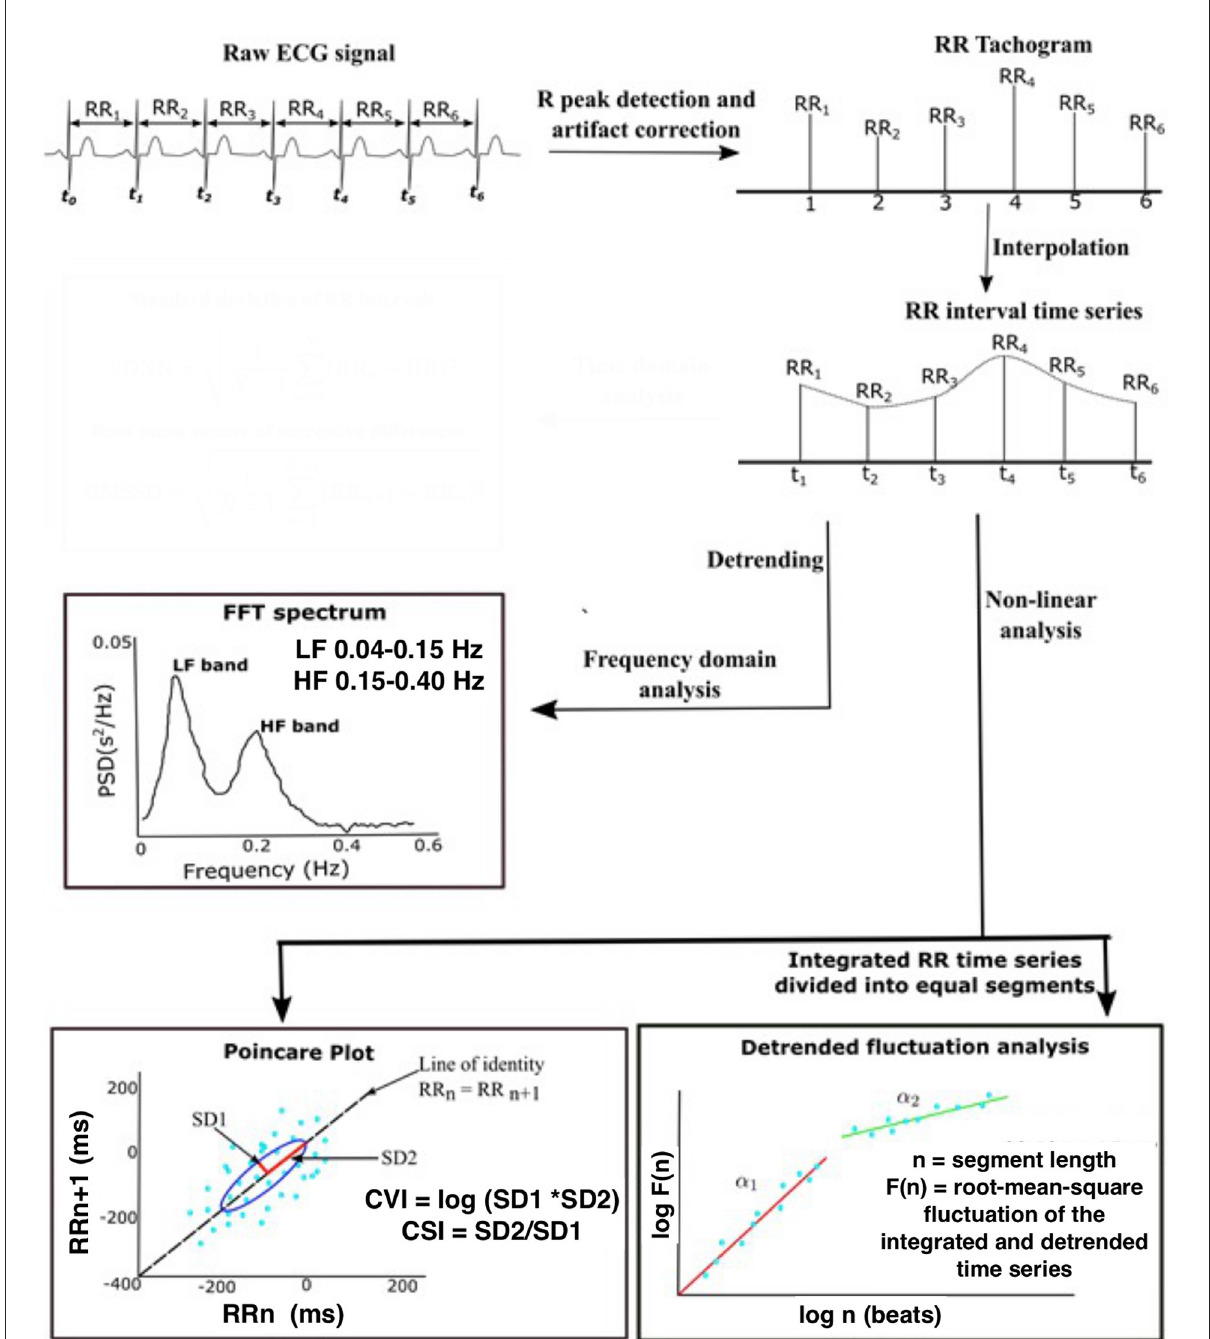
FIGURE1 Schematic demonstrating the steps in the analysis of heart rate variability. Raw ECG data were sampled at 256Hz and the 5min segment of ECG recordings was extracted from seizure-free epochs during NREM sleep. Pan–Tompkin’s algorithm was applied to compute RRi and generate an equidistantly sampled RR time series. Standard frequency domain HRV measures included normalized power of variability in two standard frequency bands HF (0.15–0.4Hz) and LF (0.04–0.15Hz). The Poincaré plot is a scatter plot representing the correlation between consecutive RRi. SD1 represents the standard deviations of the points perpendicular to the line of identity, while SD2 represents the standard deviation of the points along the line of identity. DFA measures the correlations within the data for different time scales. Variability is characterized by the slope of the regression line obtained as alpha1 (range of 4–16 beats) and alpha 2 (range of 16–64 beats). The slope ranges in value from 0.5 (random) to 1.5 (correlated). ECG, electroencephalogram; NREM, Non-Rapid eye movement sleep; R-R, R-R peak interval; FTT, Fast Fourier transform; HF, High-frequency filter; LF, Low-frequency filter; CVI, cardiac vagal index; CSI, cardiac sympathetic index; SD1, Standard deviation direction perpendicular; SD2, standard deviation direction diagonal. Adapted from Goswami et al.